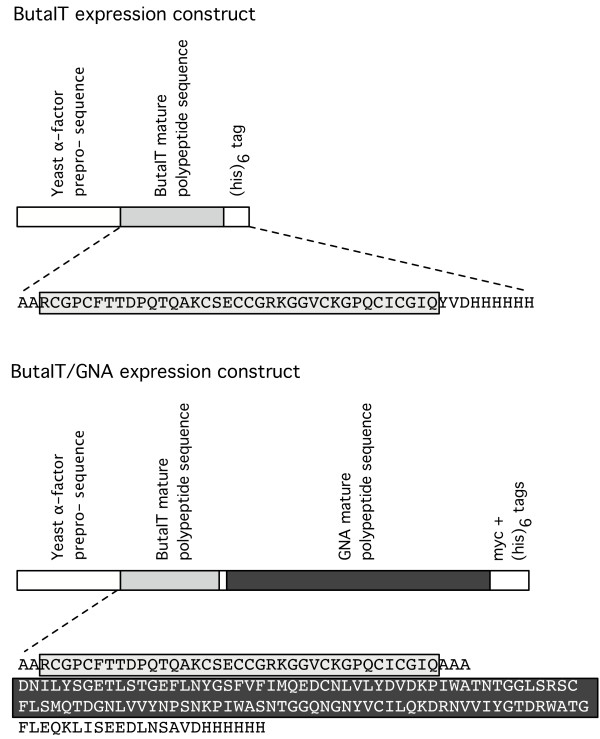
Assembly of the expression constructs for ButaIT and ButaIT/GNA. The predicted sequences of the mature proteins produced by the P. pastoris expression system are shown.